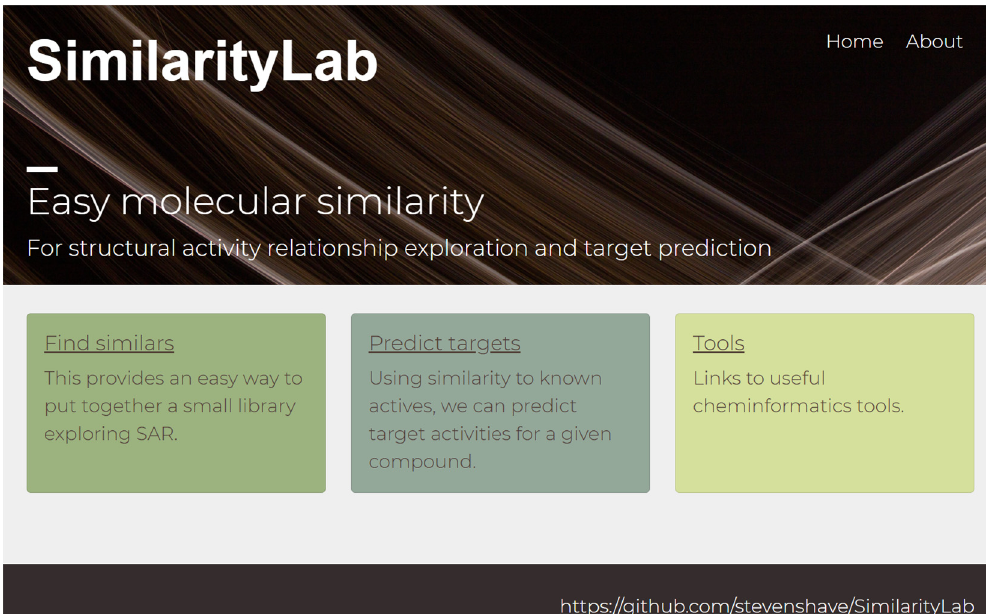
Figure 2. Landing page of the SimilarityLab website, allowing access to further interfaces for searching commercial chemical space for molecules highly similar to an input query compound, as well as target prediction for user’s supplied queries.